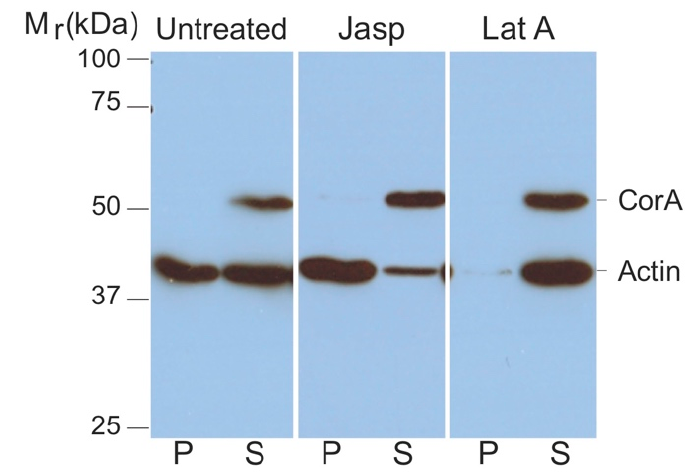
Figure 2. Coronin A-F-actin interaction within cells. Cells were either left untreated ( left ) or treated with Jasplakinolide ( middle ) or Latrunculin A ( right ). The cells were lysed in 200 µ L F-actin stabilization buffer and F-actin and G-actin were separated by ultracentrifugation of the lysate as described in Materials and Methods. The pellet was resuspended in the exact same volume as the original lysis volume. Proteins in the supernatant (S) or pellet (P) fractions were separated by SDS-PAGE and immunoblotted for coronin A and actin. Shown are representative results from at least four independent experiments.